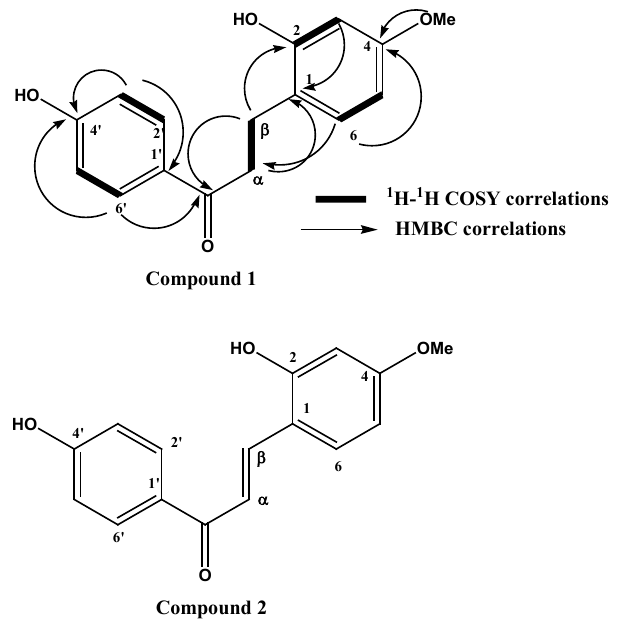
Figure 1. Chemical structure of the isolated chalcones. Table 1. 1 H (500 MHz) and 13 C NMR (125 MHz) spectral data of compounds 1 and 2 in CD 3 OD.